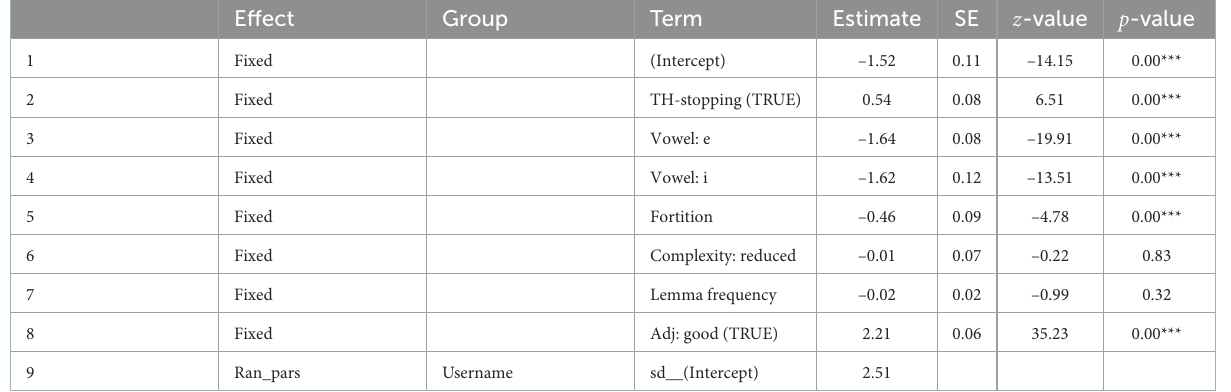
TABLE 3 Results of logistic regression on the subset of data comprising authors who tweeted 10 +